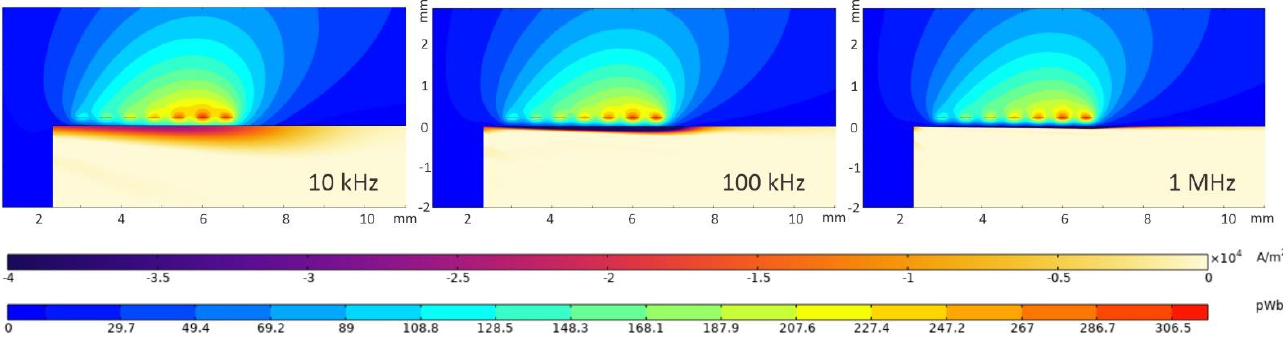
Figure 7. Magnetic flux in the air domain and current-density distribution in the part at coil driving frequencies of: 10 kHz, 100 kHz, and 1 MHz.